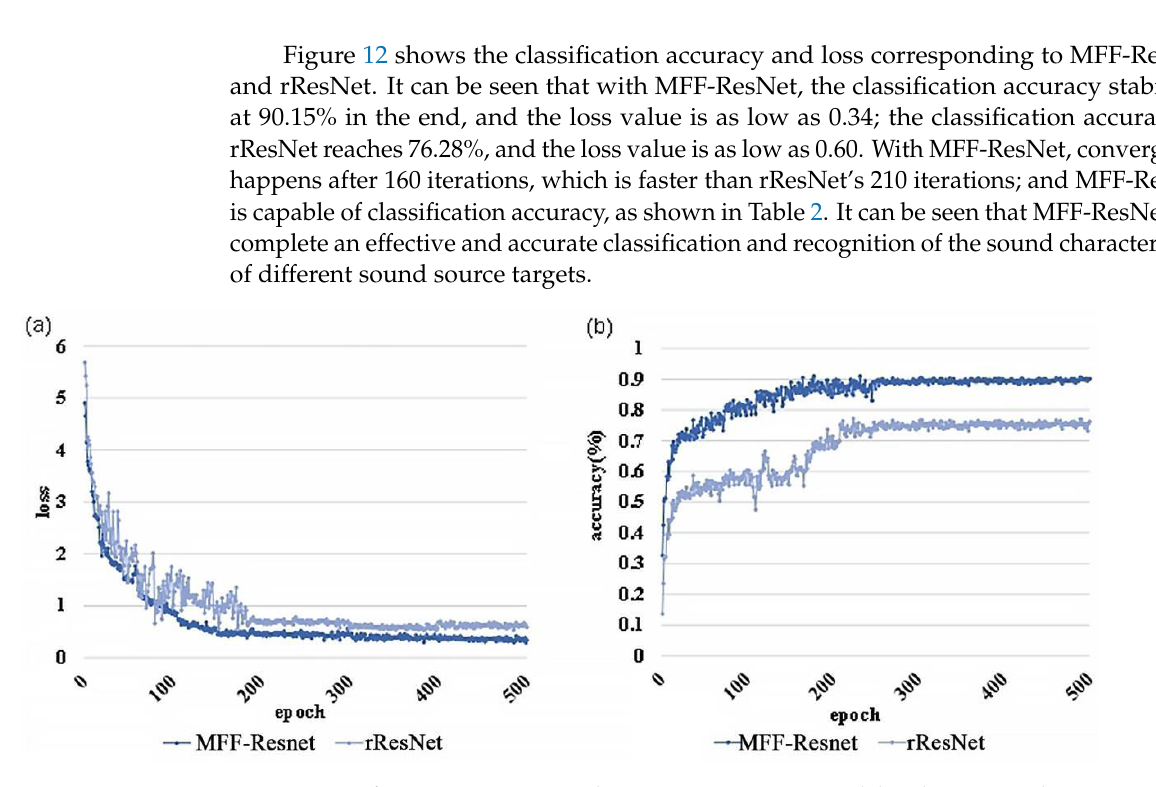
Figure 12. Performance comparison between MFF-ResNet model and pre-trained rResNet: Panels ( a , b ) show the changes in loss and accuracy with the number of epochs in network